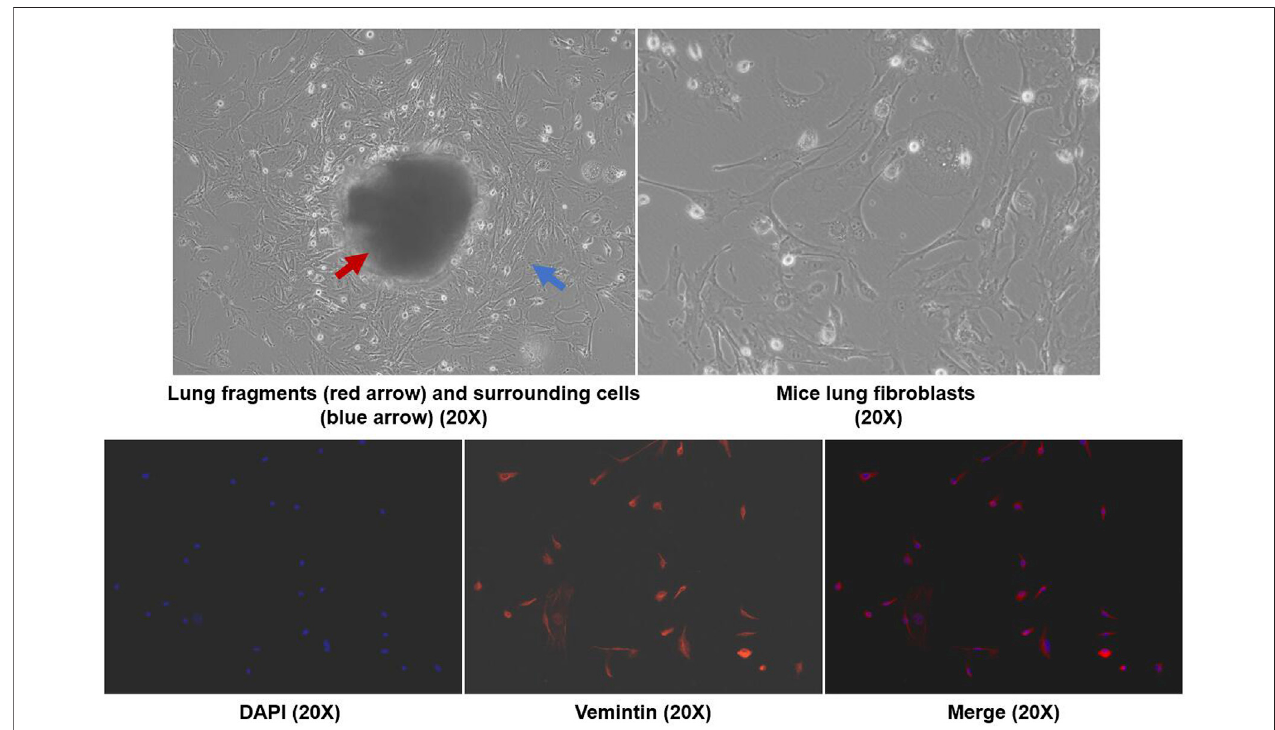
FIGURE5| Mice primary lung fi broblasts wereisolatedby crawloutmethod, and theimmuno fl uorescencewith anti-vimentin antibody wasused toidentifythe cell purity ( × 200 magnetization).